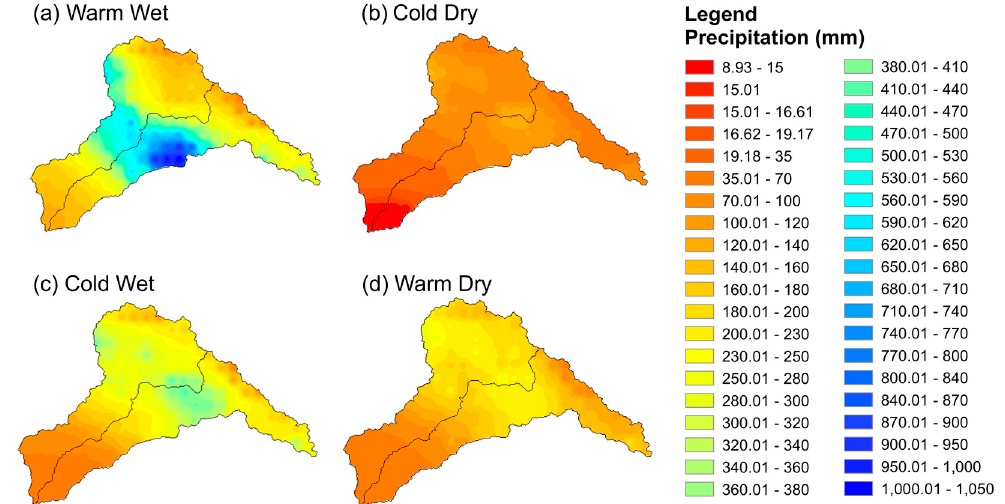
Figure 1. Topography of the study area with the grid points / stations and observed gauging station used in the study.